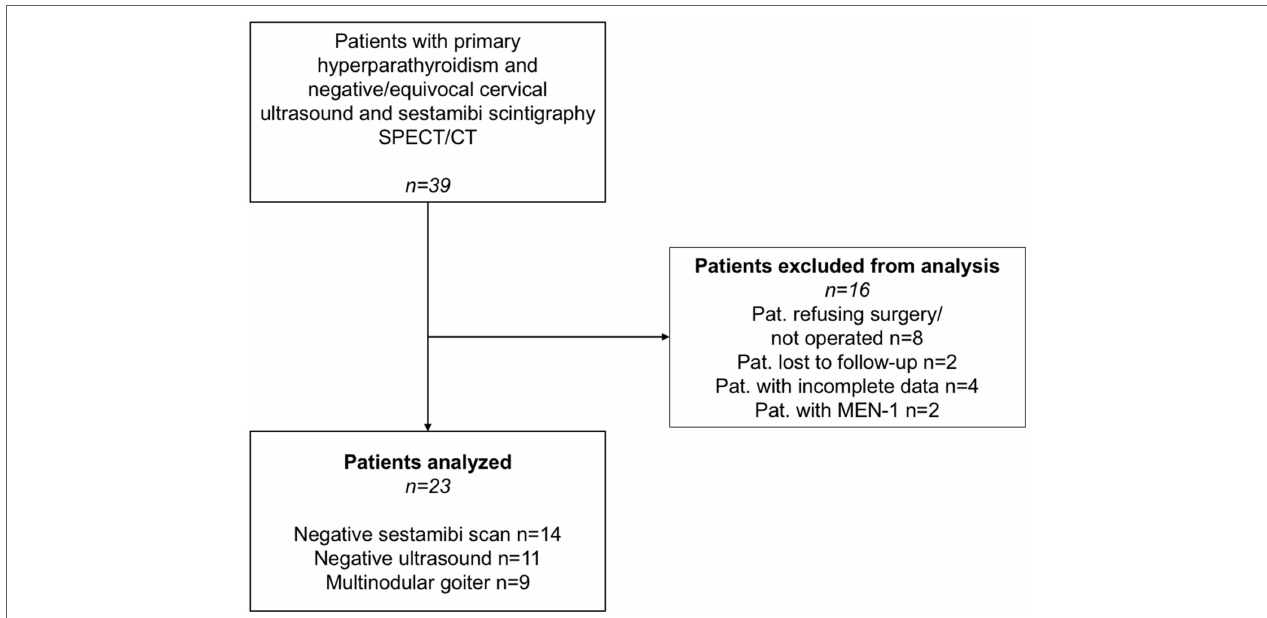
FigUre 1 | Screening and enrollment of